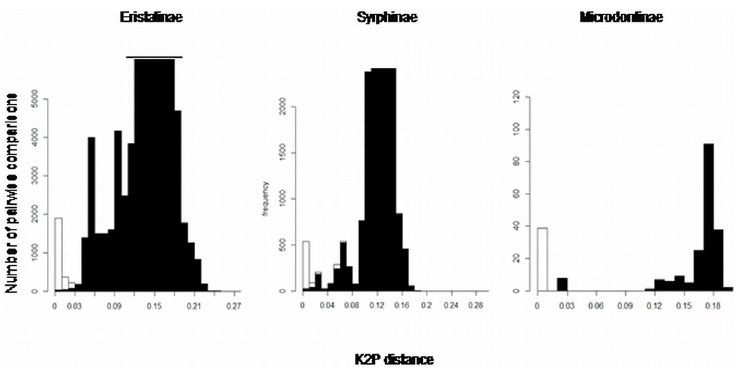
Fig 4. Frequency histogram of congeneric (open bars) and intraspecific (filled bars) Kimura 2-parameter (K2P) distances within three Central Afrotropical hoverfly subfamilies, based on COI barcodes.